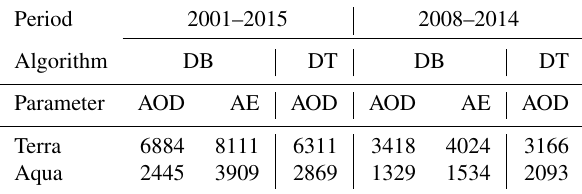
Table 3. Number of available non-negative AOD a , AOD t , AE a and AE t data. They are spatially coincident with the Camagüey sun pho- tometer in a radius of 25km for each retrieval algorithm, DB and DT for the whole period 2001–2015 as well as the period 2008–2014, when sun photometer data, AOD SP and AE SP , are available.